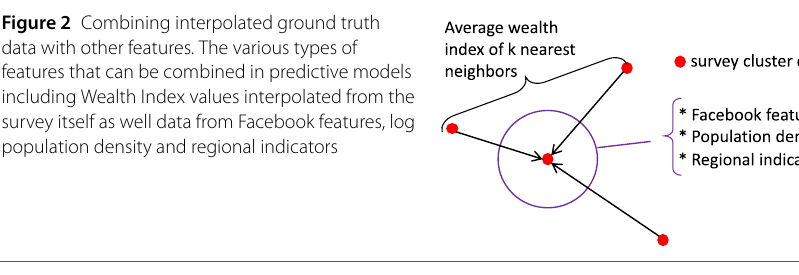
Figure 2 Combining interpolated ground truth data with other features. The various types of features that can be combined in predictive models including Wealth Index values interpolated from the survey itself as well data from Facebook features, log population density and regional